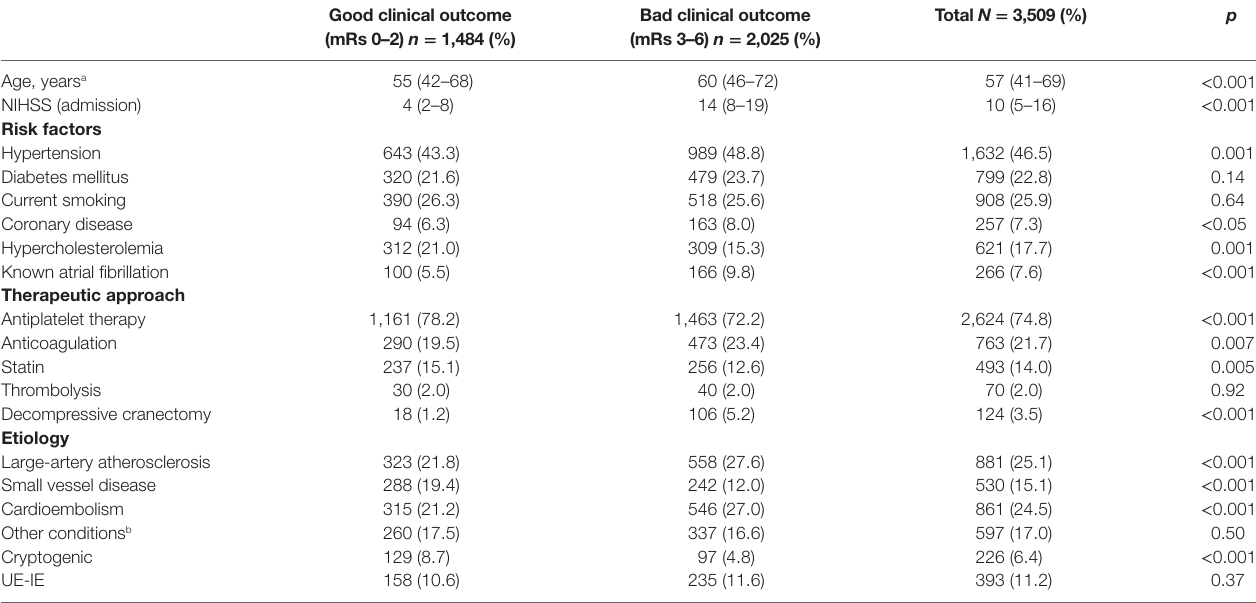
TaBle 1 | General features and vascular risk factors according to clinical outcome at discharge modified Rankin scale (mRs) in patients with ischemic